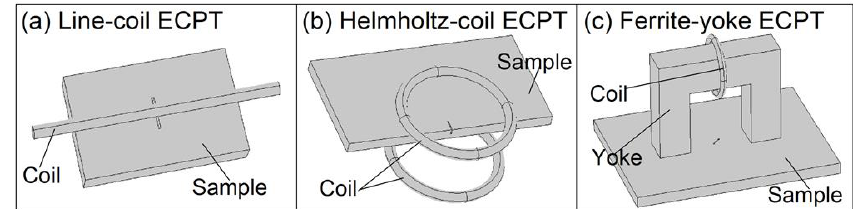
Figure 4. Numerical modeling for ECPT simulation with different configurations. ( a ) Line-coil ECPT. ( b ) Helmholtz-coil ECPT. ( c ) Ferrite-yoke-based ECPT.